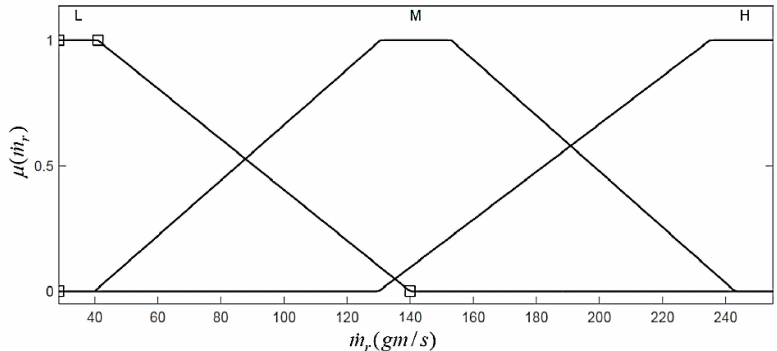
Figure 14. Membership functions of refrigerant mass flow rate.